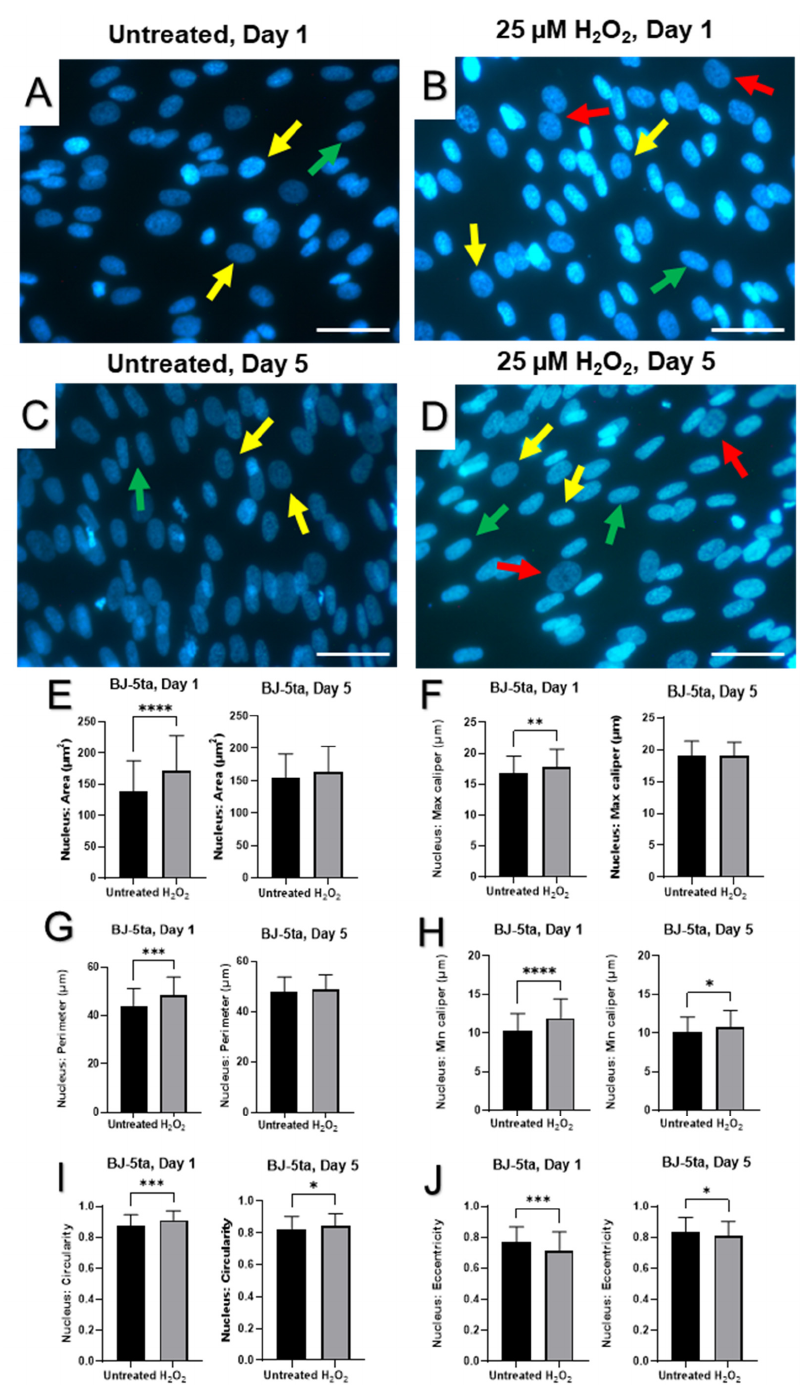
Figure 5. DAPI-stained nuclei of dermal fibroblasts (BJ-5ta), p.42 (one-step model). Pictures ( A – D ) represent nuclear changes observed by immunofluorescence microscopy on days 1 and 5 after a single 25 µ M of H 2 O 2 exposure. Arrows depict changes in nuclear shapes: yellow—round, green— elongated, and red—gigantic/irregular. ( A ) Untreated cells on day 1; ( B ) prematurely aged fibroblasts after 25 µ M of H 2 O 2 exposure on day 1; ( C ) untreated cells on day 5; ( D ) senescent fibroblasts on day 5. Nuclear parameters measured utilizing QuPath in each sample: ( E ) nuclear area; ( F ) nuclear max caliper; ( G ) nuclear perimeter; ( H ) nuclear min caliper; ( I ) nuclear circularity; ( J ) nuclear eccentricity. Data were analyzed with a Student’s unpaired t -test for each separate parameter. Significance is indicated within the figures using the following scale: *, p < 0.05; **, p < 0.01; ***, p < 0.001; ****, p < 0.0001. Bars represent mean ± SD. Scale bars = 20 µ